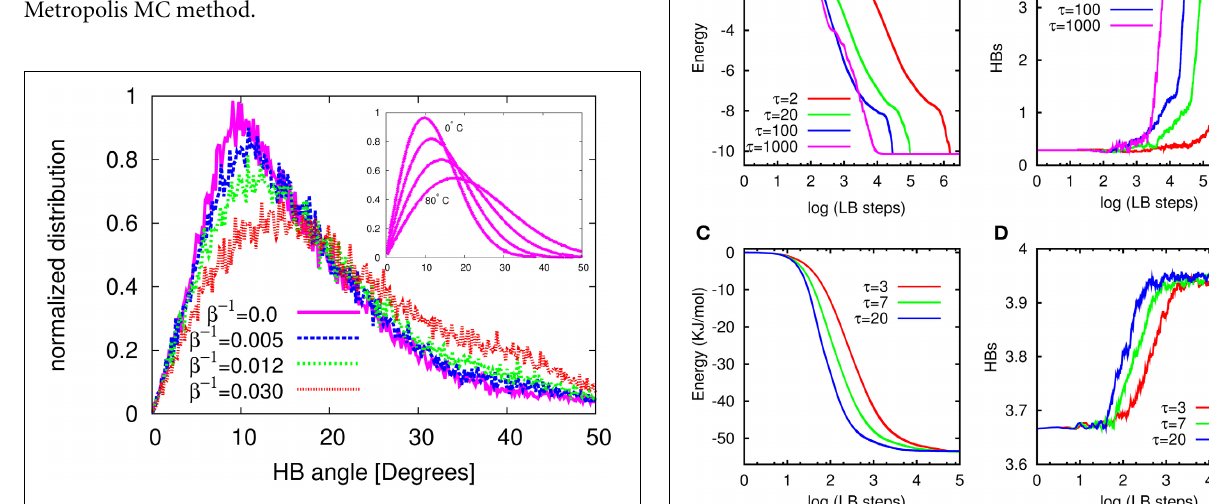
FIGURE 10 | Energy and number of HB vs. LB steps at different τ : (A,B) for LBN3d and (C,D) for